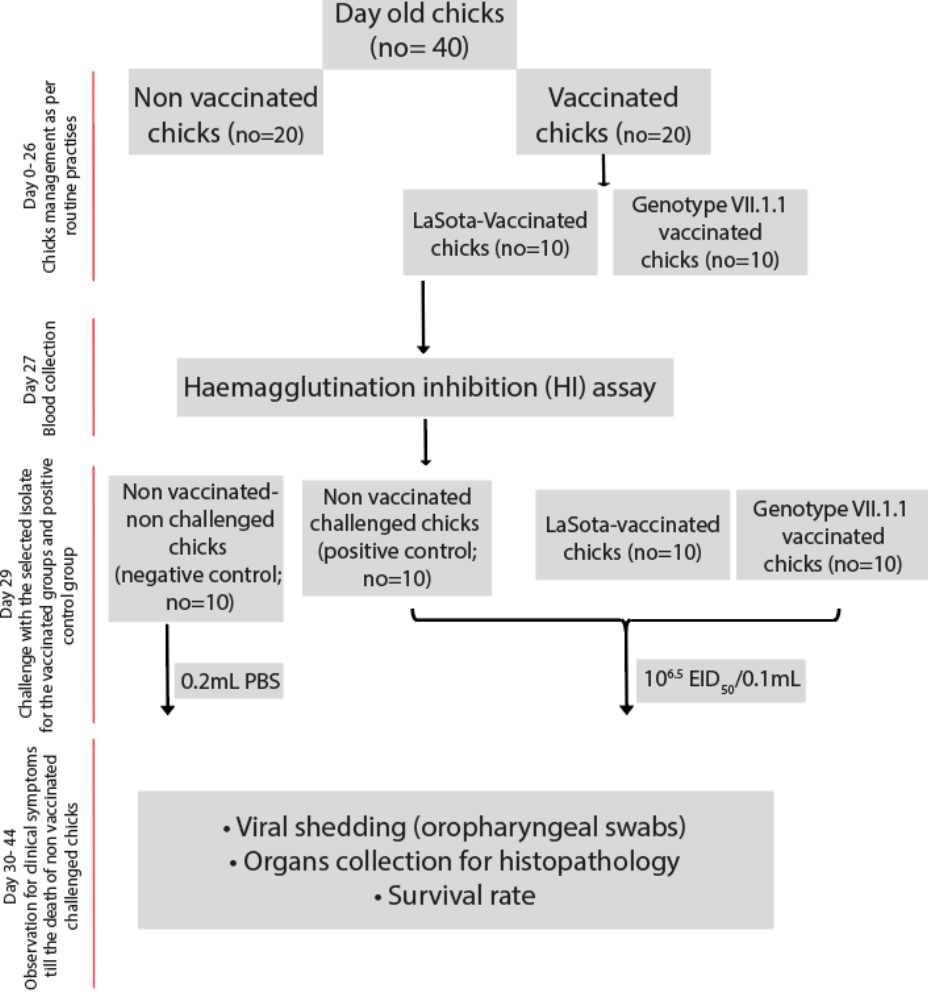
Figure 1. Experimental layout for the assessment of vaccines effectiveness in chicks .